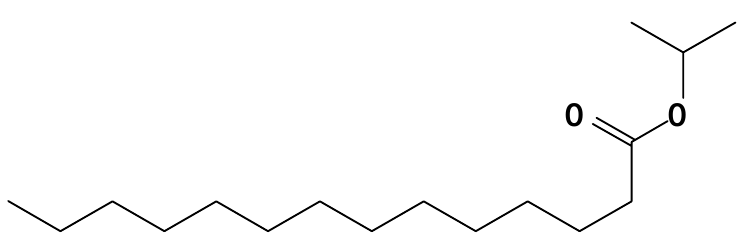
Figure1. Chemical structure of Isopropyl myristate